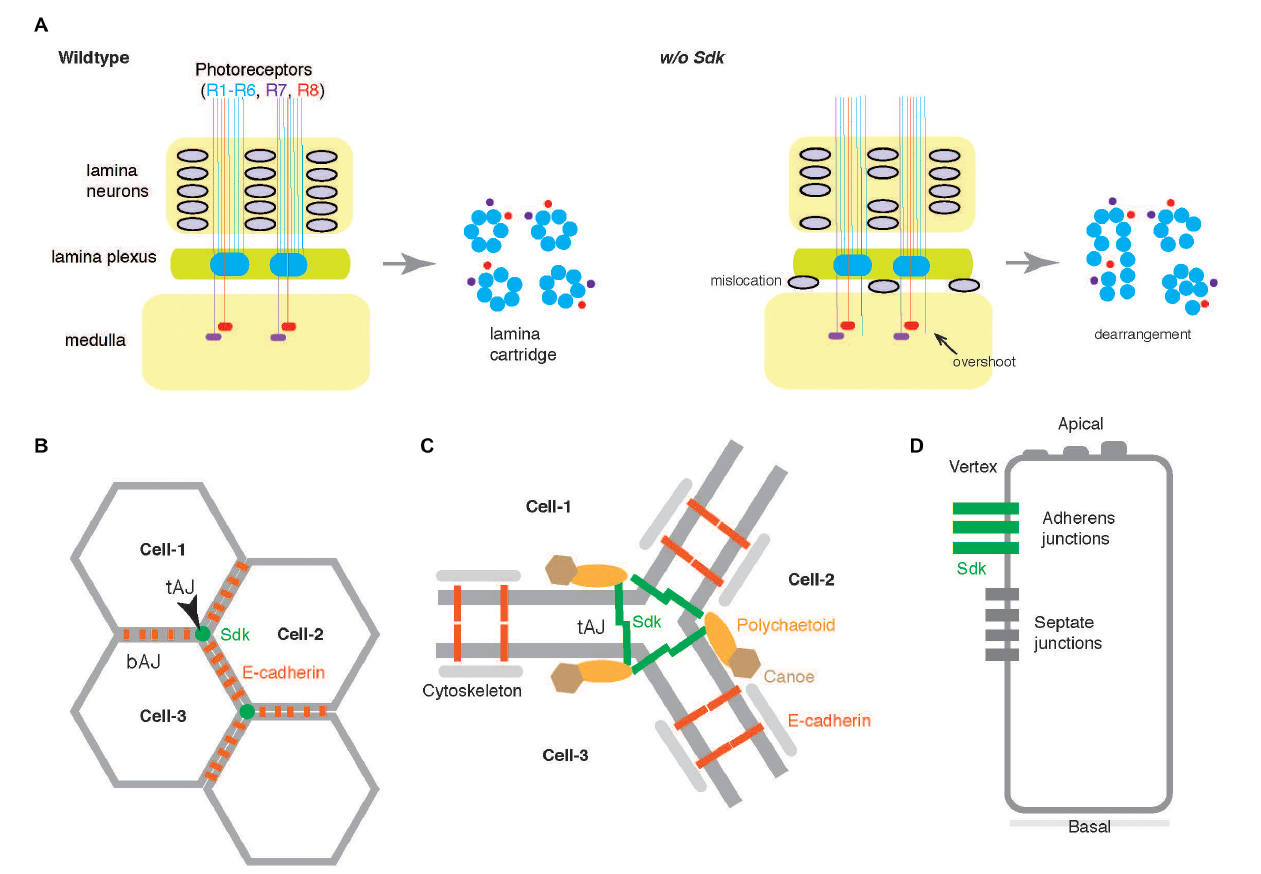
FIGURE 4 | Functions of Sdk in Drosophila . (A) The compound eyes of the Drosophila visual system consist of many ommatidia. Each ommatidium contains eight photoreceptors that project to either lamina (R1–R6) or medulla (R7 and R8). In the lamina plexus, a group of axons from both R1–R6 photoreceptors and lamina neurons make a plexus, which later organized as a lamina cartridge (wildtype, left). In the absence of Sdk ( w/o Sdk , right), the lamina neurons fall off from the packed columns, and the R1–R6 axons occasionally overshoot into the medulla where R7/R8 axons normally terminate (Astigarraga et al., 2018). In the lamina cartridges, the photoreceptor axons are disorganized (transverse section at the right side). (B) Epithelial cells build adhesive contacts along their apical-basal axes, both at the bicellular adherens junctions (bAJs) and at the tricellular adherens junctions (tAJs) in Drosophila . Sdk is highly concentrated at tAJs which are at the vertex of three mature epithelial cells (Cell-1, Cell-2, and Cell-3) whereas E-cadherin participates in forming bAJ (Finegan et al., 2019; Letizia et al., 2019; Uechi and Kuranaga, 2019) (B) . (C) At tAJs, the Sdk protein functionally links to Polychaetoid ( Figure 3 ) and Canoe, modulates dynamically E-cadherin by associating with actomyosin cytoskeletons during development, and maintains epithelial sheets. (D) Lateral view. In insects, epithelial cells also contact to adjacent cells at septate